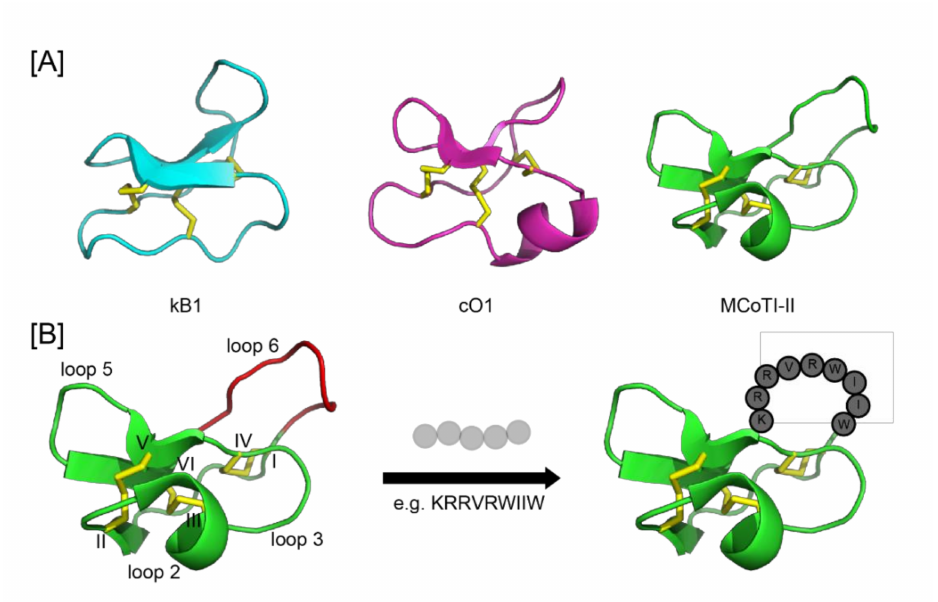
Figure 1. Structures of cyclotides. ( A ) Cartoon representations of the Moebius cyclotide kalata B1 (kB1, PDB ID: 1NB1), the bracelet cyclotide cycloviolacin O1 (cO1, PDB ID: 1NBJ), and the Momordica trypsin inhibitor II (MCoTI-II, PDB ID: 1HA9). ( B) The principle of cyclotide grafting, showing the cyclic cystine knot motif with disulfide bonds highlighted in yellow. Cysteine residues are numbered in Roman numerals and intercysteine loops labelled. Loop 6 (highlighted in red) can be used to stabilize linear epitopes, such as the antimicrobial peptide optP7 used in this study. This concept, known as molecular grafting, results in engineered cyclotides with a range of desired